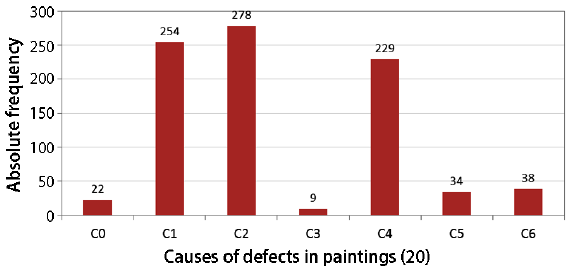
Fig. 20. Absolute frequency of the general groups of causes in paintings (20)